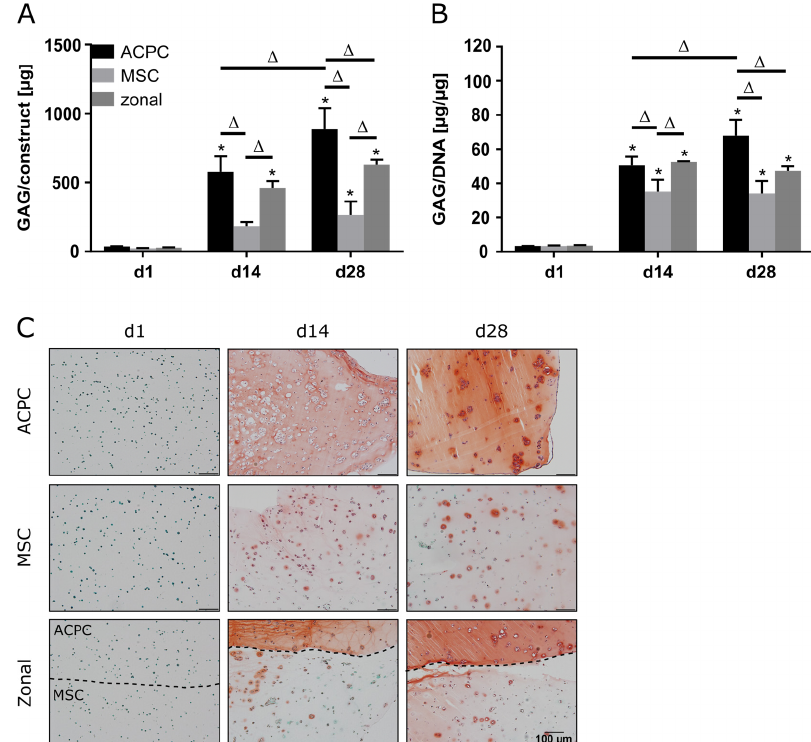
Figure 1. Glycosaminoglycan (GAG) production in articular cartilage progenitor cell (ACPC), mesenchymal stromal cell (MSC), and zonal constructs under normoxic conditions. Biochemical and histological analysis of GAG in agarose hydrogel constructs, seeded with 20.0 × 10 6 cells mL − 1 , after 1, 14, and 28 days of chondrogenic differentiation under normoxic conditions. ACPCs and MSCs were either cultured alone or in zonally layered co-culture constructs. ( A ) Production of total GAG (GAG/construct) and ( B ) GAG normalized to DNA (GAG/DNA). Data are presented as means ± standard deviations ( n = 3 biological replicates). Note: (*) indicates statistically significant differences between a day 14 (d14) or day 28 (d28) value and the corresponding day 1 (d1) value of the same group ( p < 0.05); ( Δ ) indicates statistically significant differences between groups, or within a group between time points ( p < 0.05). ( C ) Histological safranin-O staining for visualization of produced GAG. In zonal constructs, the upper layer contained ACPCs and the lower layer contained MSCs (indicated by the dashed line).